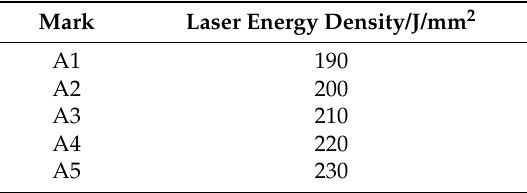
Table 1. Experimental parameters.